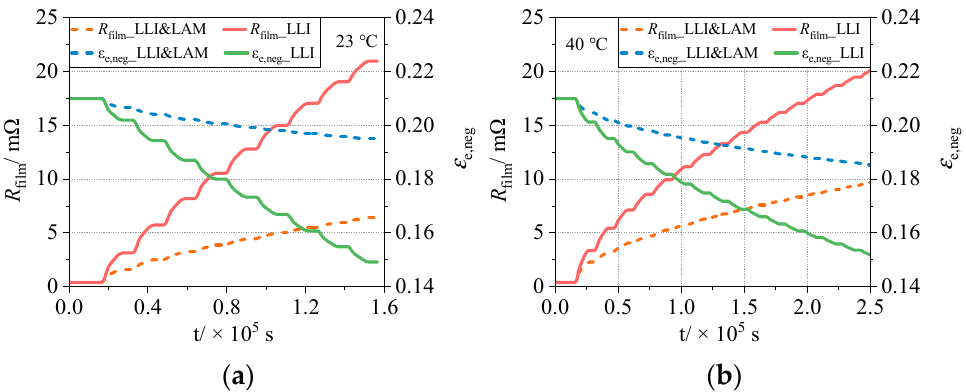
Figure 19. Variations in SEI film resistance and anode porosity under different aging modes at ( a ) 23 ◦ C and ( b ) 40 ◦